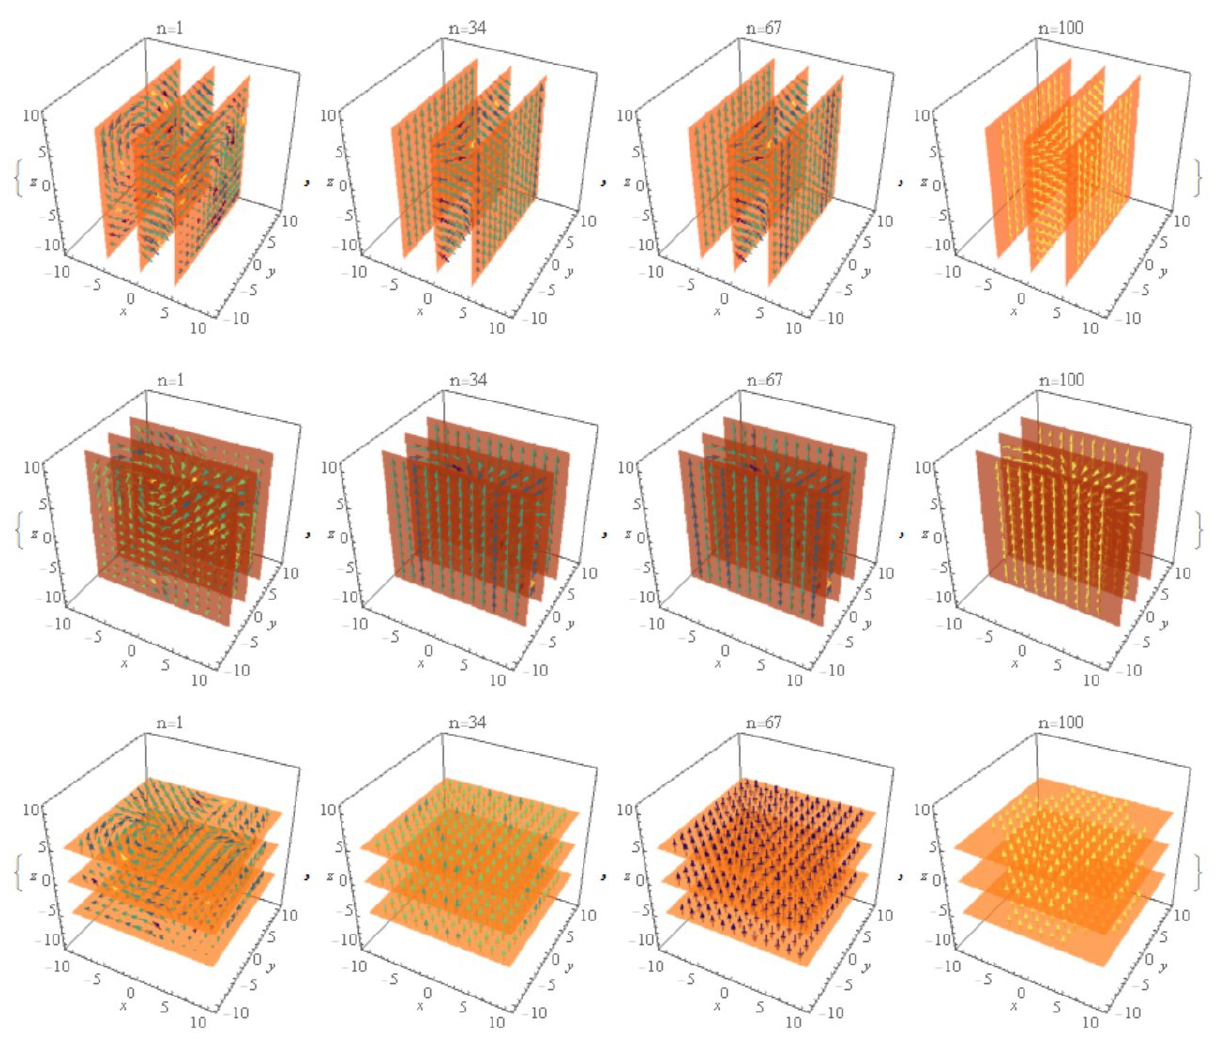
Fig. 1 First, second and third rows from top, x -stacked planes, y -stacked planes and z -stacked planes respectively are